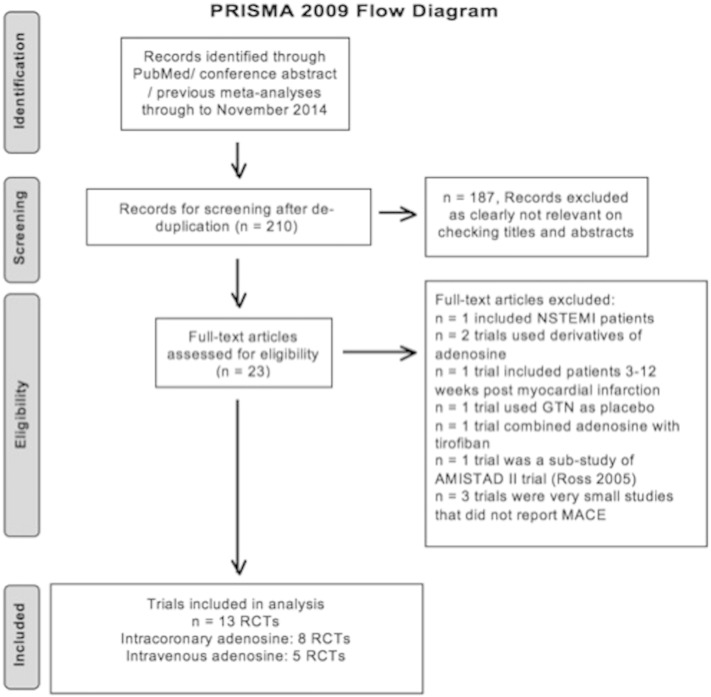
PRISMA 2009 flow diagram.